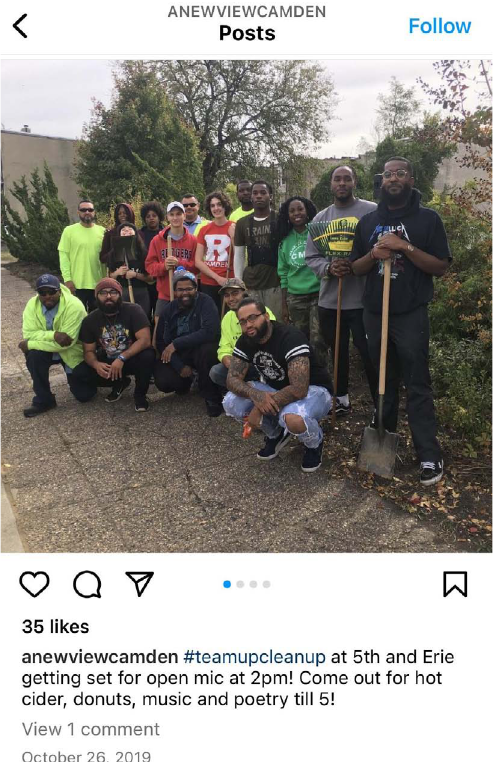
Figure 2. Instagram Post- Cleaning one of the sites with the community. Comment: Amazing.